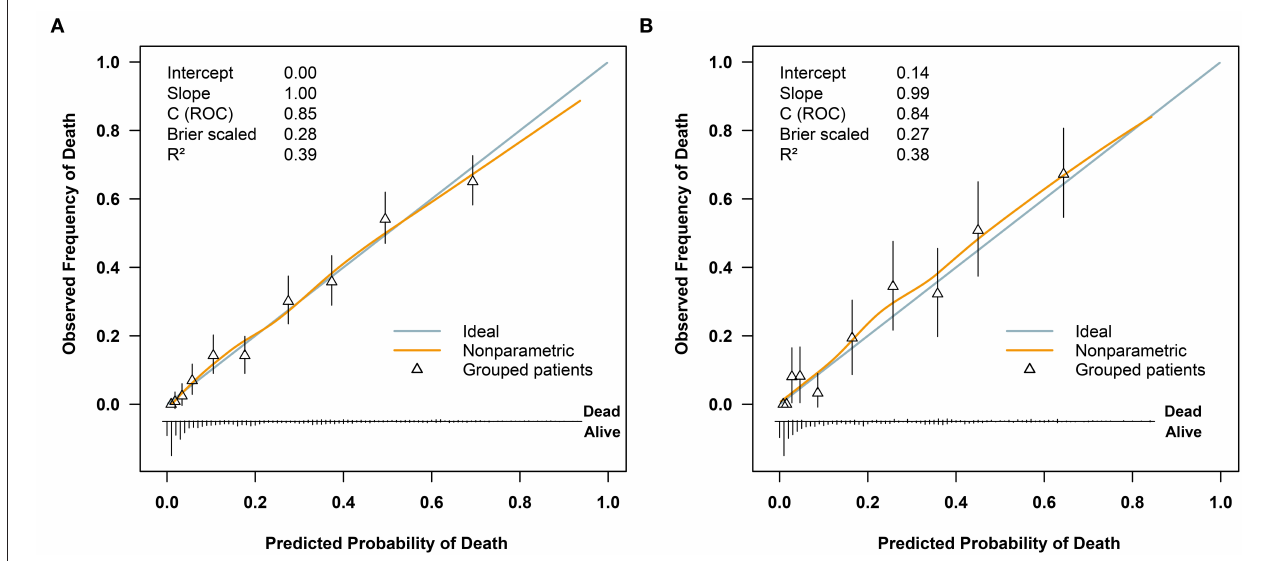
FIGURE 3 | Receiver operating characteristic curves for validating the discrimination of our model and included variables: (A) in the training cohort ( n = 2461) and (B) in the validation cohort ( n = 614). ISS, injury severity score; GCS, Glasgow Coma Scale; BE, base excess.